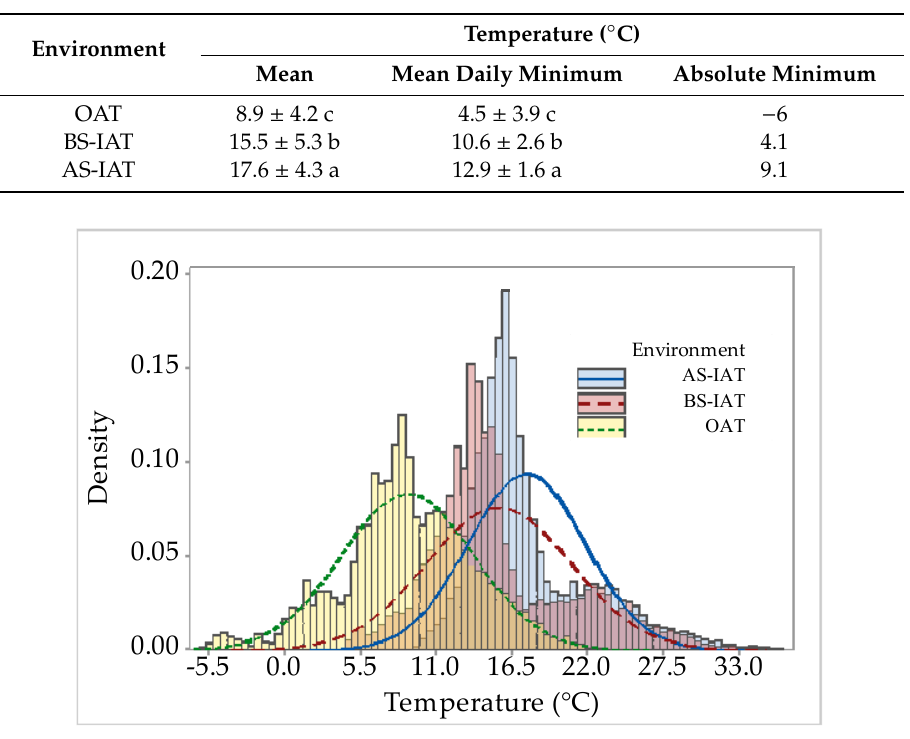
Figure 8. Density of temperature distribution of the OAT (outside air temperature) and the IAT (inside air temperature) in the AS (air-heating section) and BS (basal-heating section) of the greenhouse.